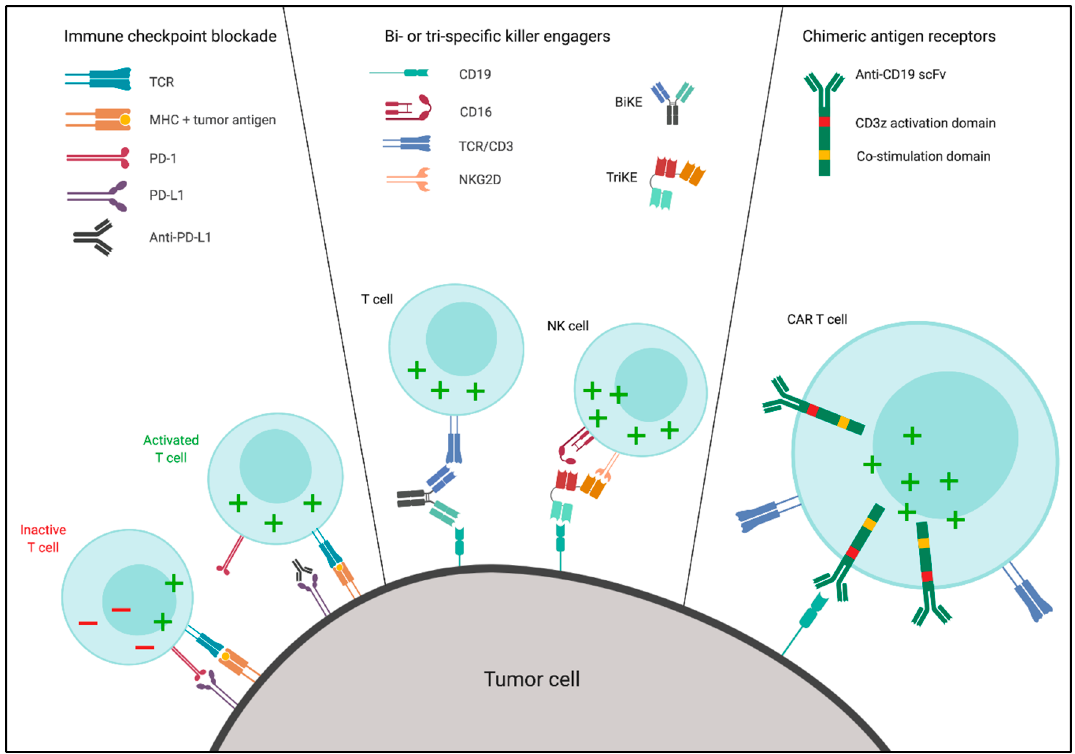
Figure 1. Overview of immunotherapeutic strategies. The left panel explains the mechanism of immune checkpoint blockade therapy, which prevents signaling by inhibitory receptors on cytotoxic lymphocytes, and unleashes tumor-specific immune responses. Programmed cell death protein 1 / programmed death-ligand 1 (PD-1 / PD-L1) blockade is given here as an example, but antibodies blocking cytotoxic T-lymphocyte-associated protein 4 (CTLA-4) were also approved, while other inhibitory receptors on T and natural killer (NK) cells may be targets for future strategies. The middle panel shows the mode of action of bi- and tri-specific killer engagers (BiKE and TriKE, respectively). Cytotoxic lymphocytes are recruited by one antibody arm of the construct, while the other arm binds to the tumor cell. In these examples, tumor cells are targeted via cluster of di ff erentiation 19 (CD19), while T cells or NK cells are recruited via binding to CD3 or CD16 and NK cell receptor D (NKG2D), respectively. Due to the easy manufacturing of these constructs, many di ff erent strategies can be employed to target tumor cells and recruit e ff ector cells. The right panel represents the use of chimeric antigen receptor (CAR) therapy, which redirects the specificity of autologous e ff ector cells after CAR transduction via the extracellular single-chain variable fragment (scFv), and induces immune activation via intracellular activation and co-stimulation domains. Similar to the BiKE and TriKE constructs, CARs can be modified to target di ff erent tumor antigens. Furthermore, intracellular co-stimulation domains can vary, but most CARs contain CD28 or CD137 (4-1BB) co-stimulatory domains. Although the figure shows T cells as an example, NK cells can also be transduced with CAR constructs and used as e ff ector cells. This figure was created using